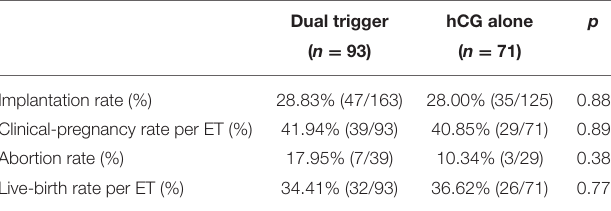
TABLE 3 | Reproductive outcome of cycles of fresh-embryo transfer in the study groups.